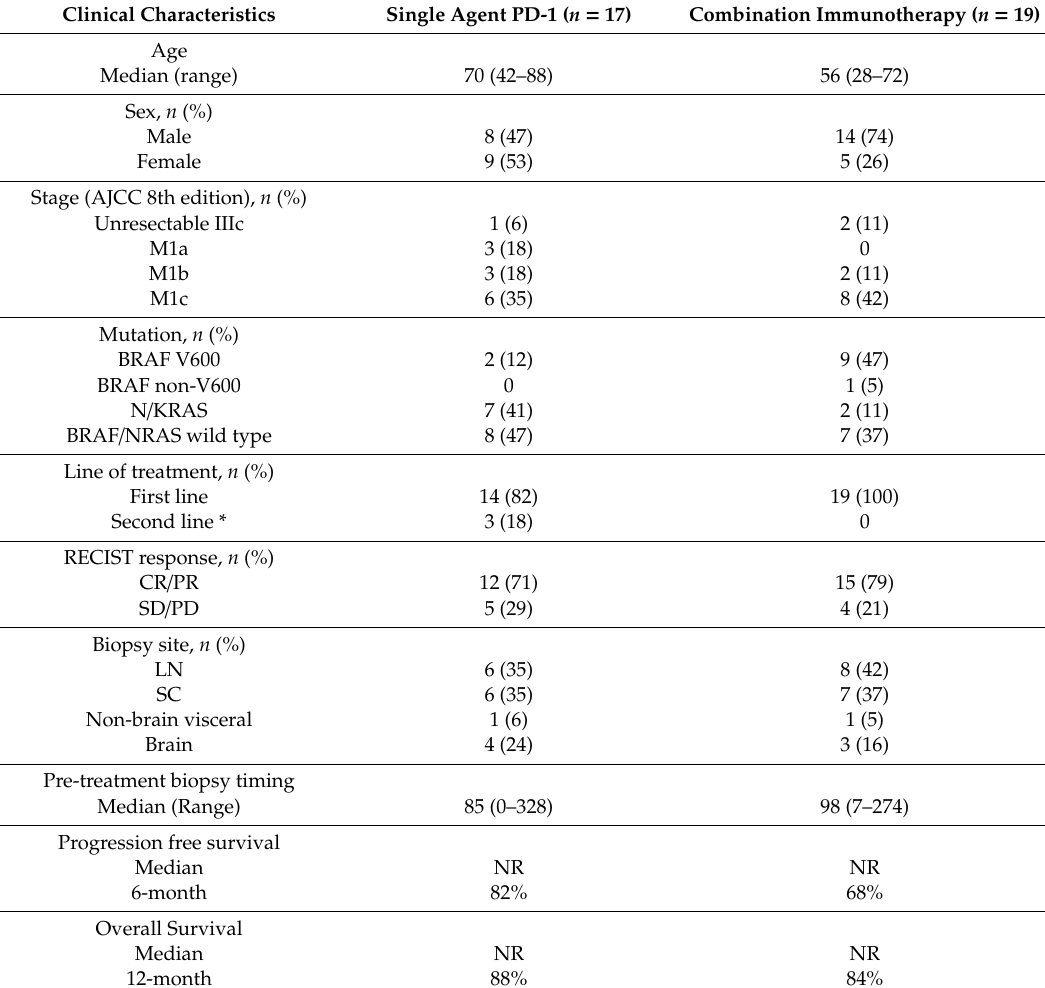
Table 1. Baseline patient